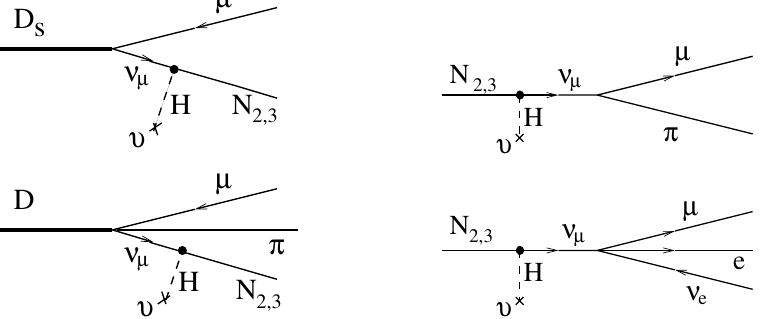
Figure 158. Feynman diagrams ( left ) for the production of HNLs and ( right ) for their decays. The dashed line denotes the coupling to the Higgs vacuum expectation value, leading to the mixing of active neutrinos and HNLs via Yukawa couplings. Figure taken from